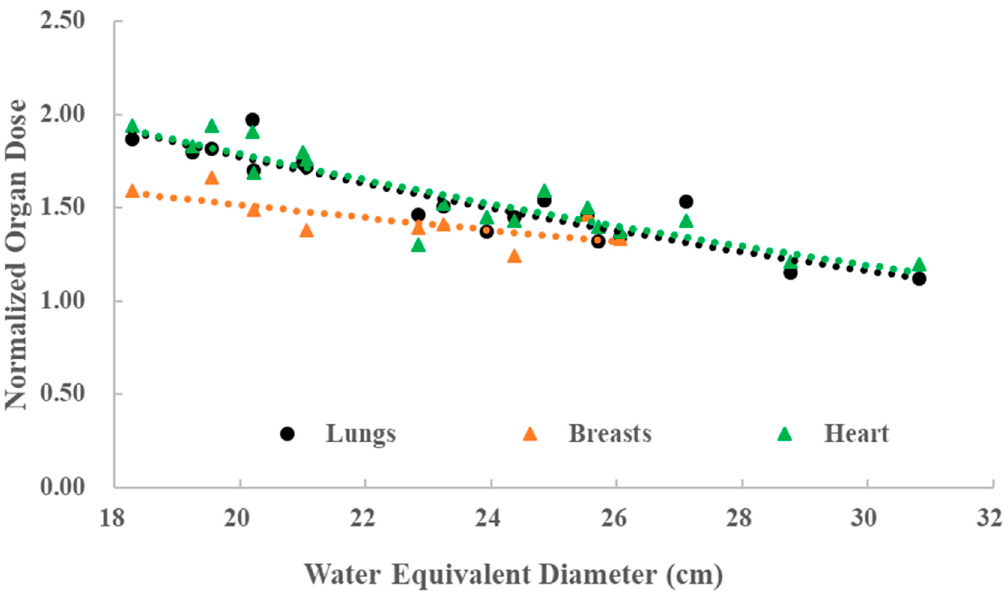
Figure 4. Normalized lung, breast, and heart doses and the WED for 18 patients. Through the regression analysis, it was also found that all of the three organ doses could be expressed in the form of the same exponential function listed below, and the coefficient of determination (R 2 ) of regression equations are 0.85, 0.81, and 0.57 for the lung, heart, and breast, respectively.